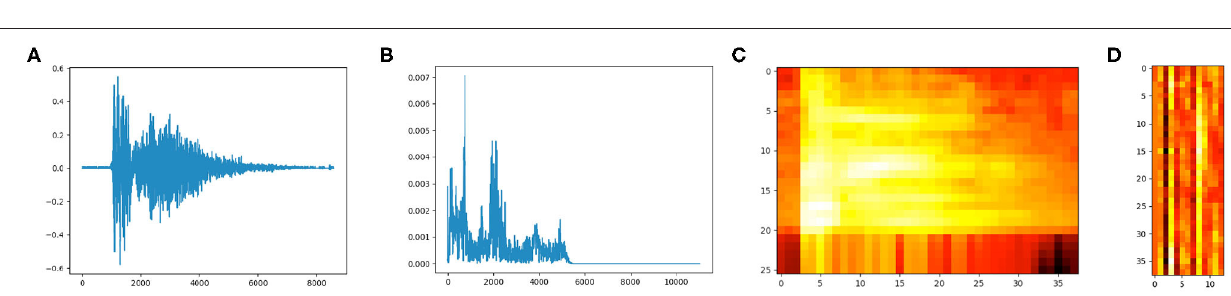
FIGURE 4 | Cough time-frequency representation analyses. (A) Cough signal 16-bit, frequency range 22050Hz. (B) Power spectrum of the cough audio frame (FFT). (C) Spectrogram. (D)